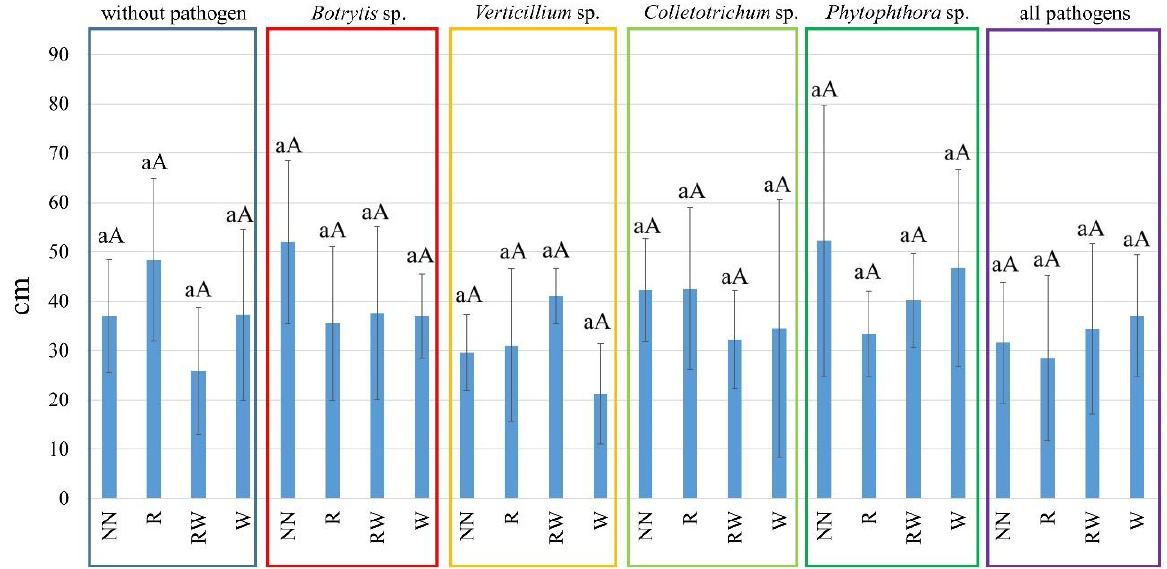
Figure A2. The early effect of the bacterial consortium on Polana raspberry plant growth in the pot experiment depended on the pathosystem and naturalization strategy applied. The average number of stems, according to pathosystems Botrytis cinerea , Verticillium sp., Colletotrichum acutatum , Phytophthora sp., and all pathogens ( Botrytis , Verticillium , Colletotrichum, Phytophthora ) and without pathogens, within different biopreparation application strategies: no naturalization (NN), root inoculations (R), root inoculations and watering (RW), and watering (W). Error bars indicate a standard deviation, n = 3, different lowercase letters above the bars indicate differences among the particular pathosystem, and different capital letters above the bars indicate differences among the particular naturalization strategies (according to ANOVA with p < 0.05).